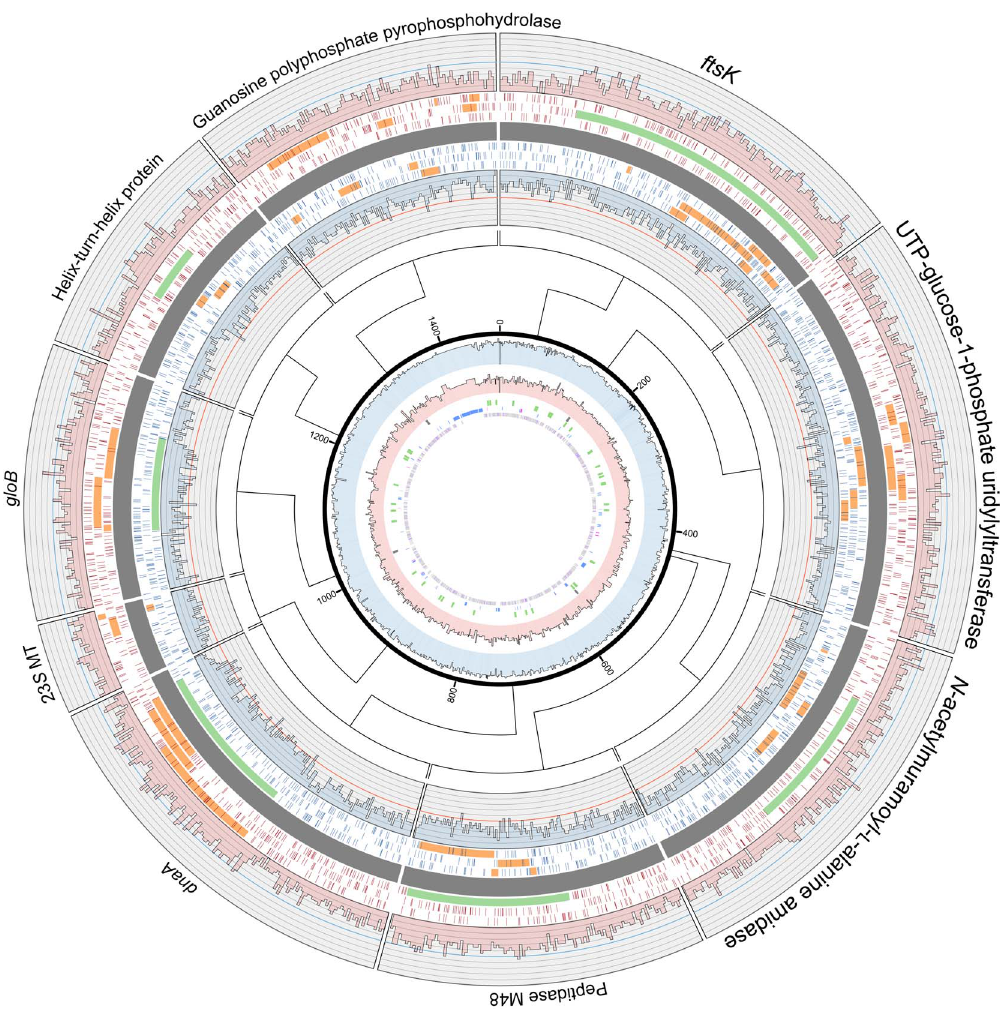
Figure 7. Recent pseudogenes in Ca. E. faulkneri L2 and L5 contain many frame-shifts and in-frame stop codons, and exhibit GC content higher than most intergenic sequences (see Table 1). Syntenic regions in Ca. E. faulkneri L2 (red, outside) and L5 (blue, inside) are shown aligned, with heatmaps showing the locations of stop codons in three frames (for simplicity, each region is shown in the same orientation, where the forward coding direction is clockwise), and GC content shown in histograms. Intact genes are shown in light green, while pseudogenous regions that show homology in BLASTX/TBLASTN searches are shown in light orange. The locations of these regions are shown in relation to the L2 chromosome